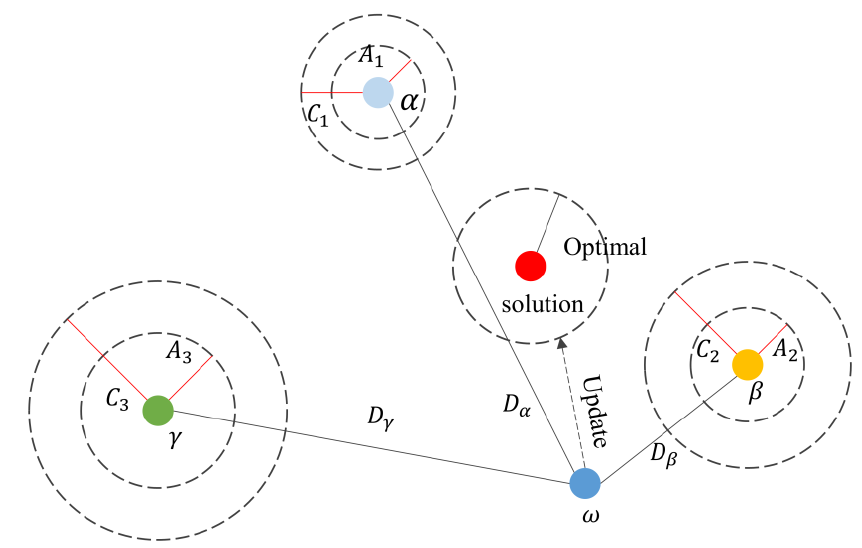
Figure 2. Schematic diagram of grey wolf location